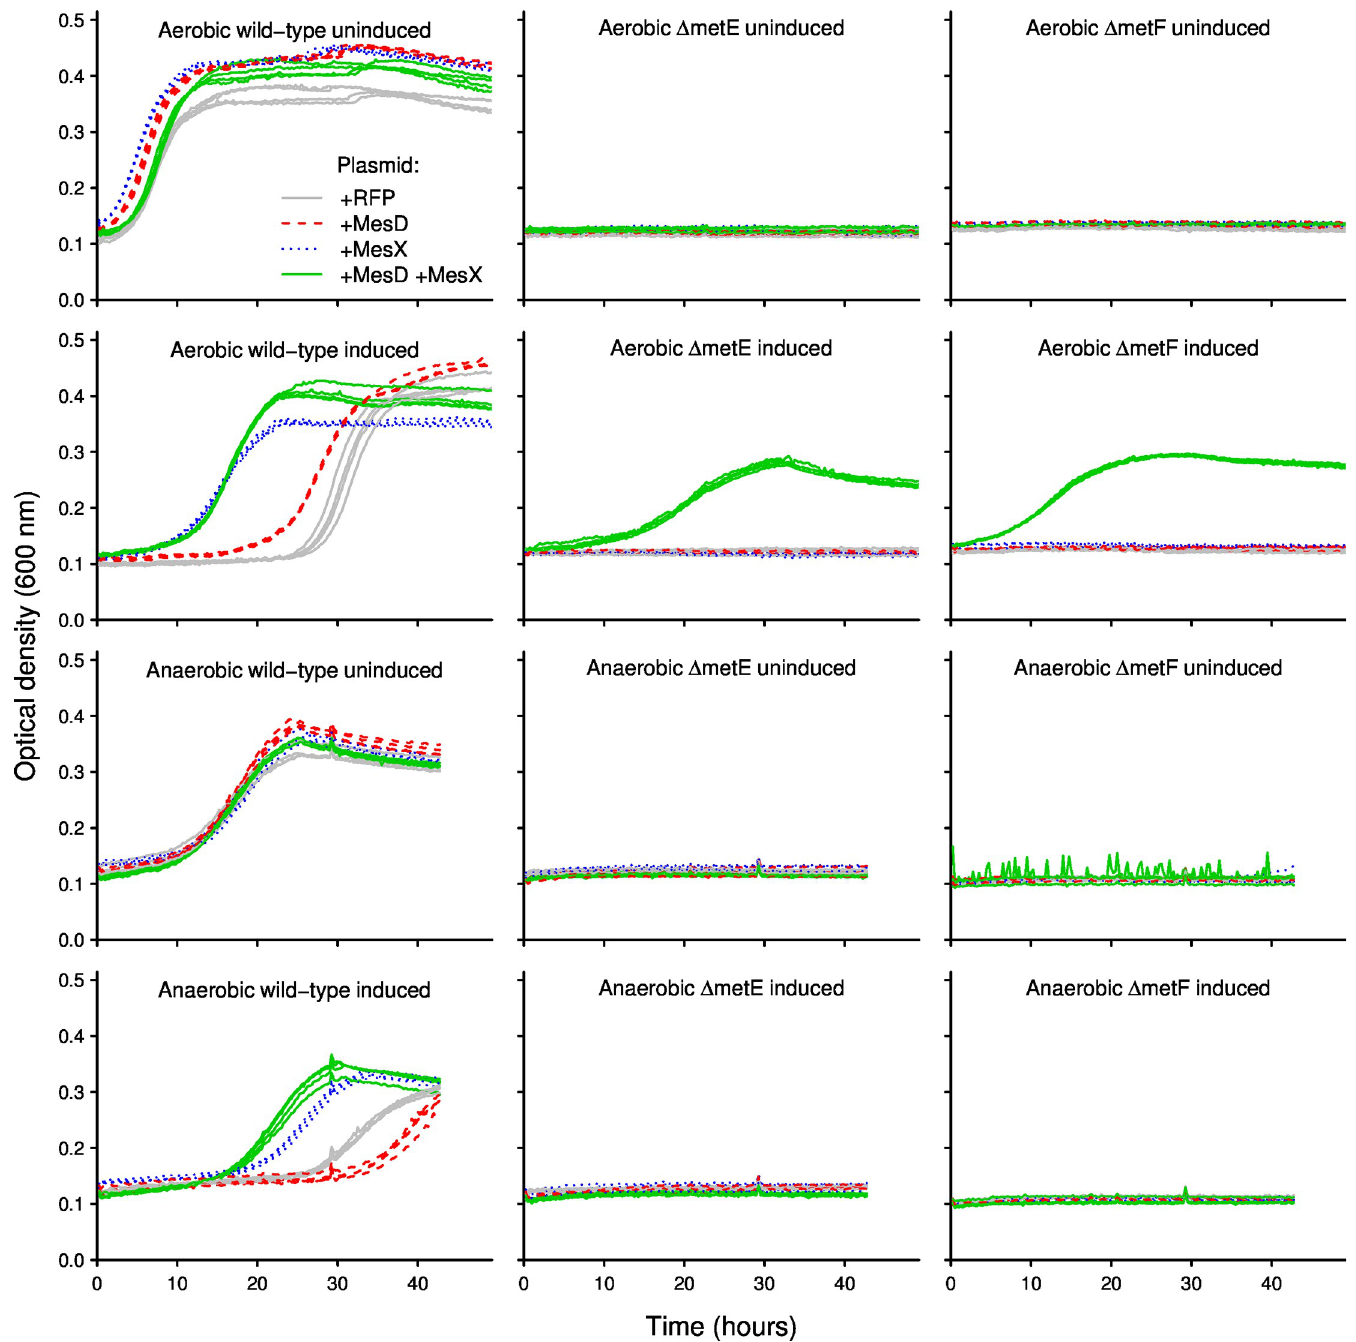
Fig 6. Complementation assays show that MesD requires MesX and oxygen for activity, but not MetF. We cloned MesD, MesX, or MesD and MesX together into strains of E . coli from the Keio collection [40] and measured growth in minimal glucose M9 medium. A plasmid bearing red fluorescent protein (RFP) was used as a